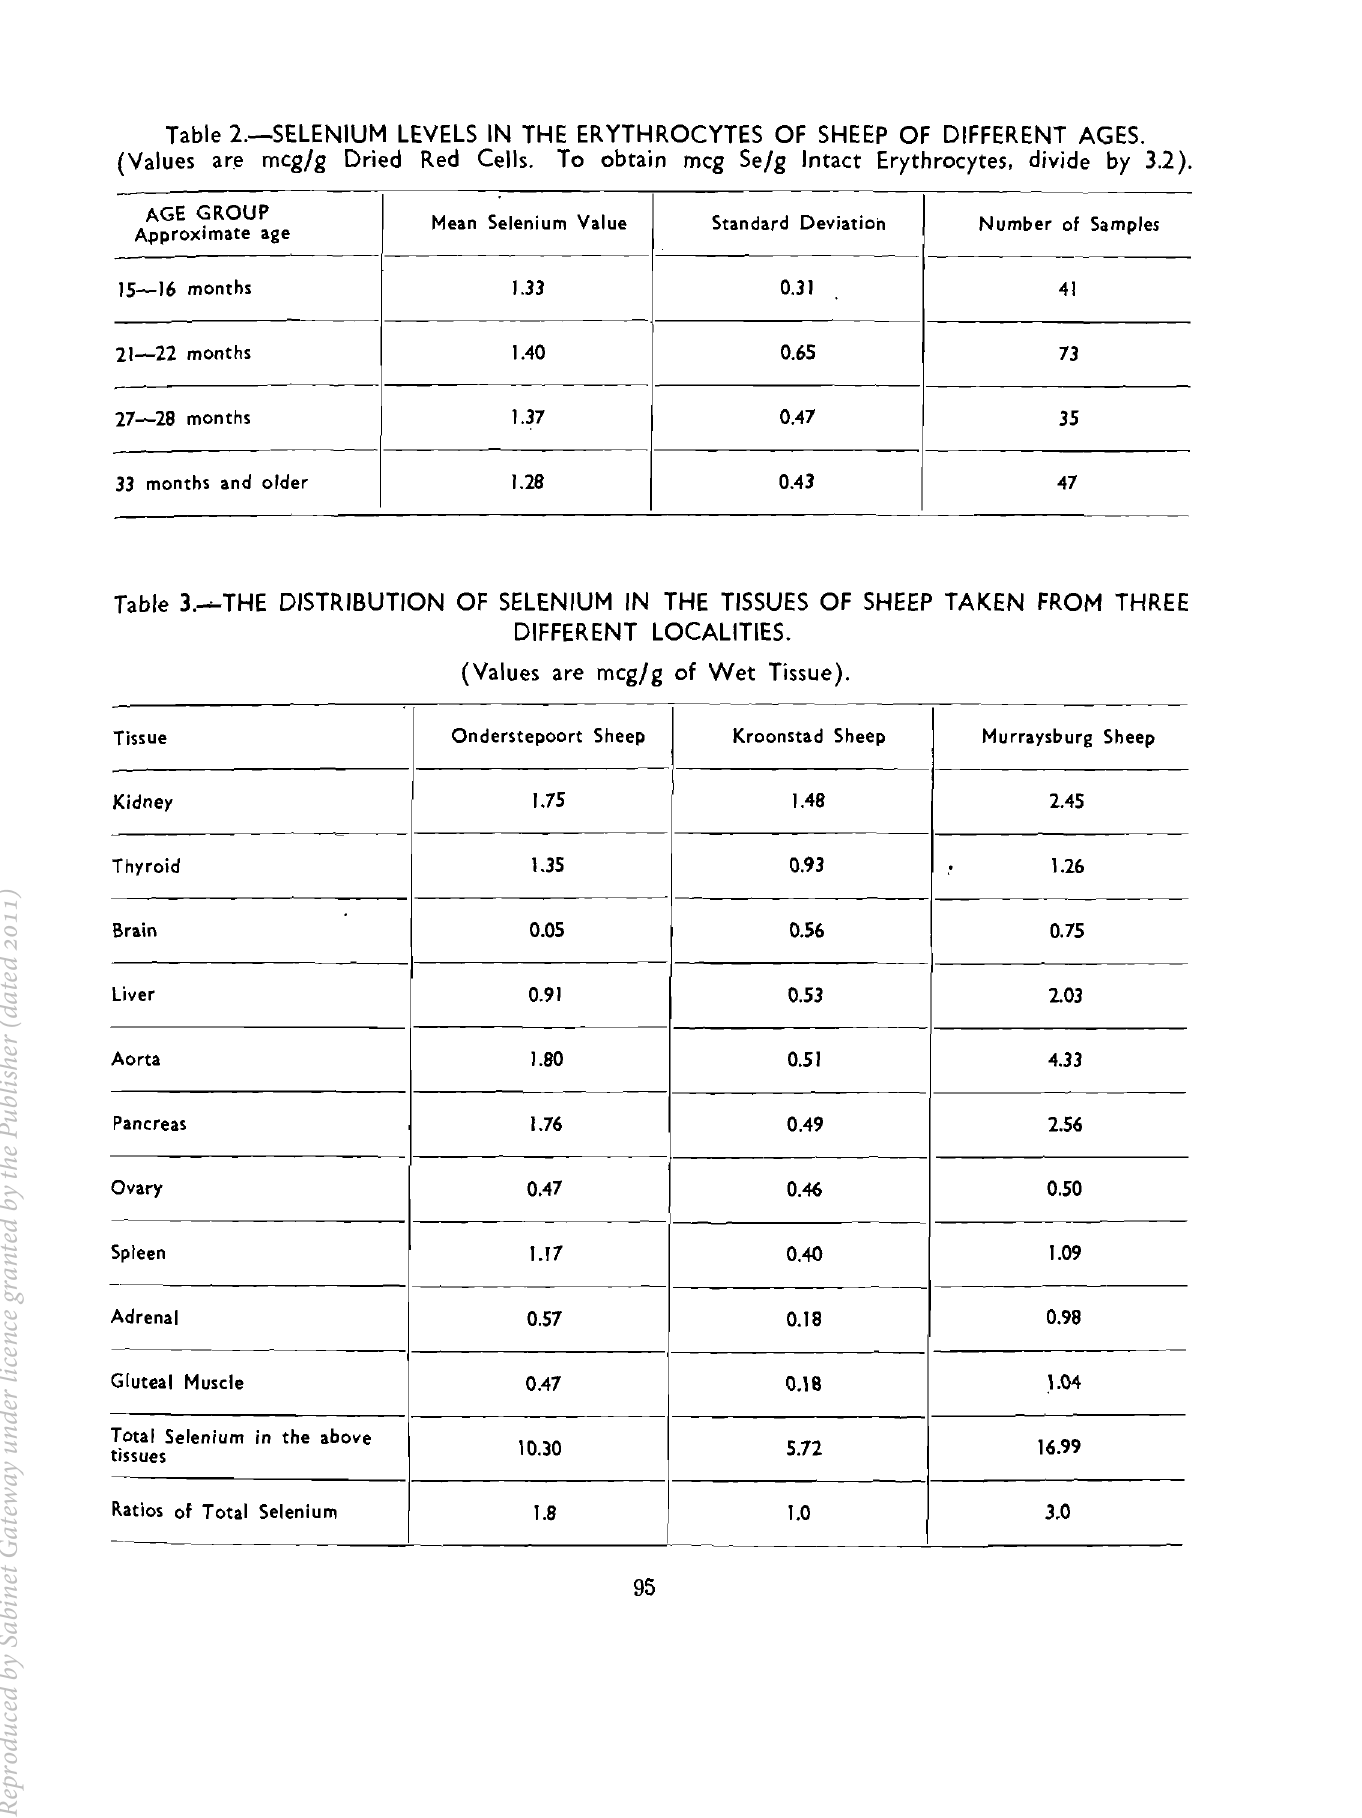
Table 2.-SELENIUM LEVELS IN THE ERYTHROCYTES OF SHEEP OF DIFFERENT AGES. (Values are mcg/g Dried Red Cells. To obtain mcg Se/g Intact Erythrocytes. divide by 3.2).